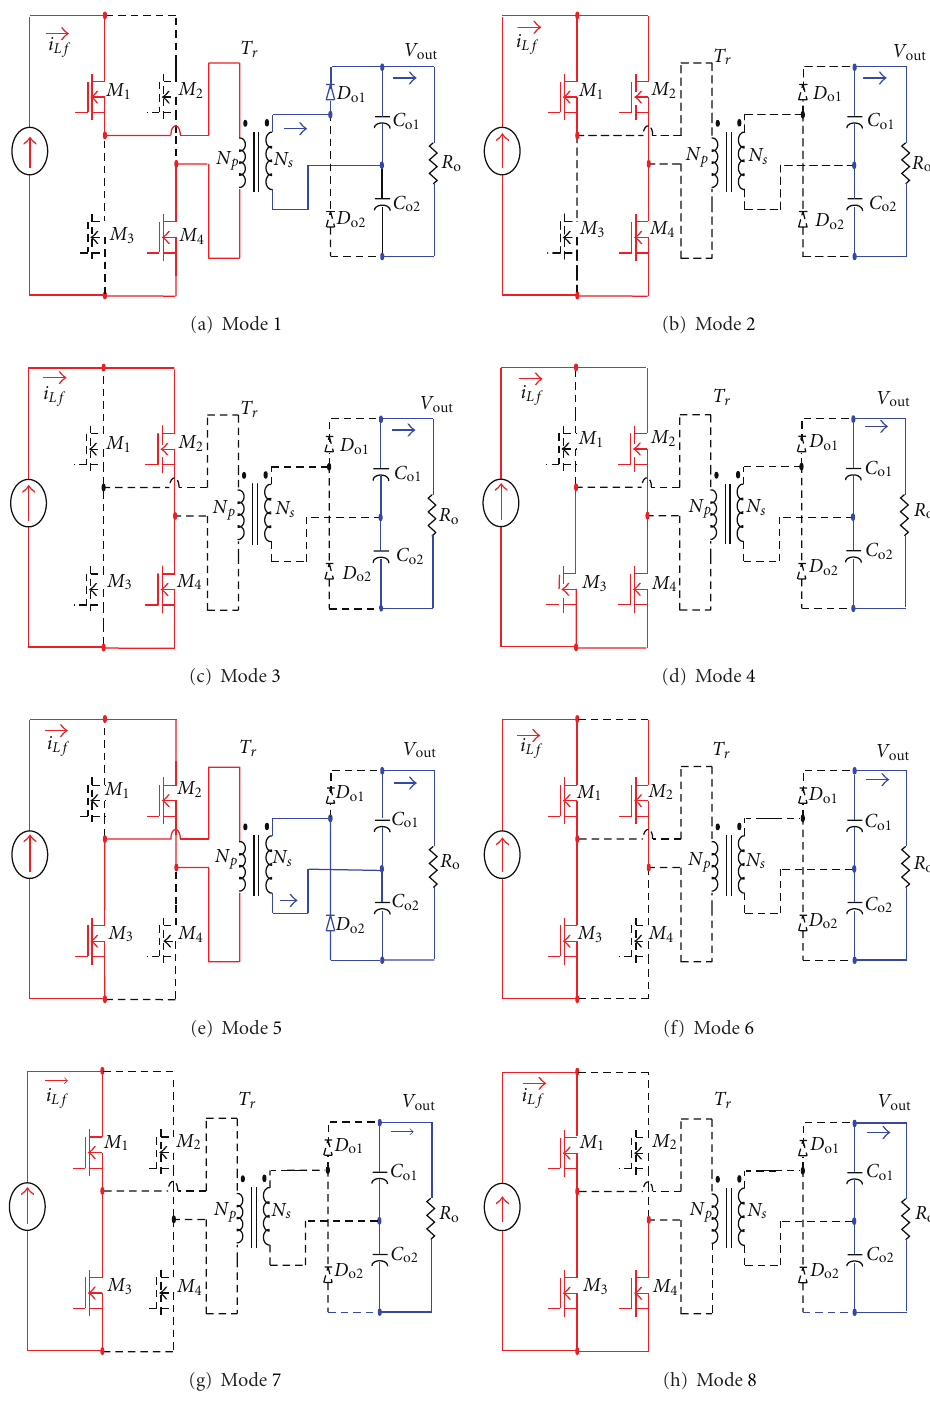
Figure 4: Equivalent circuits of operating